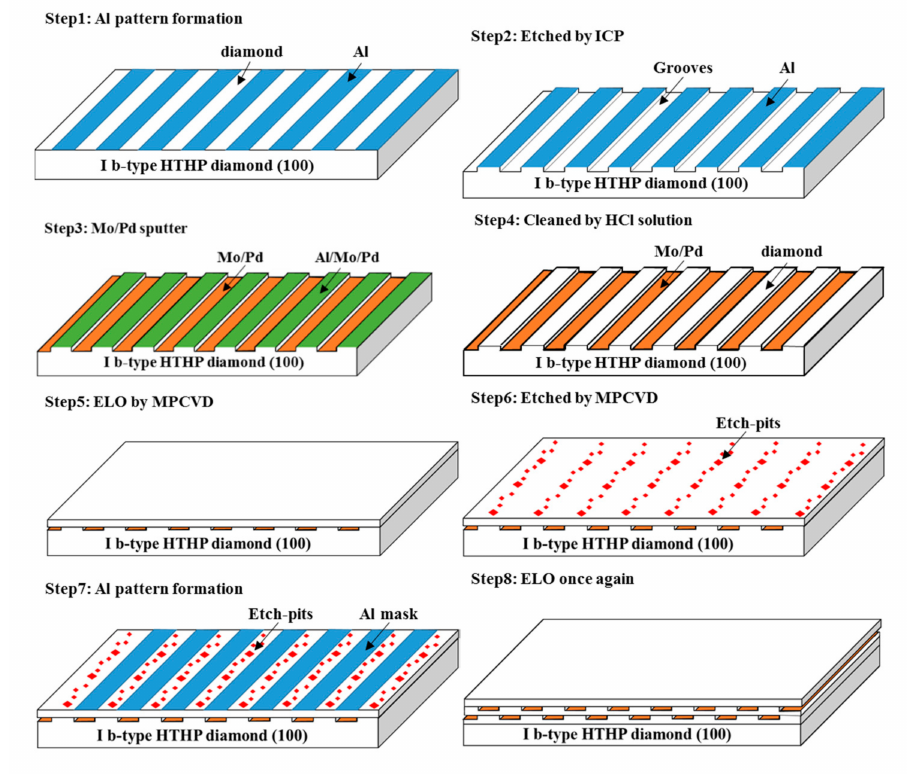
Figure 1. The schematic process diagram of the two-step epitaxial lateral overgrowth (ELO)